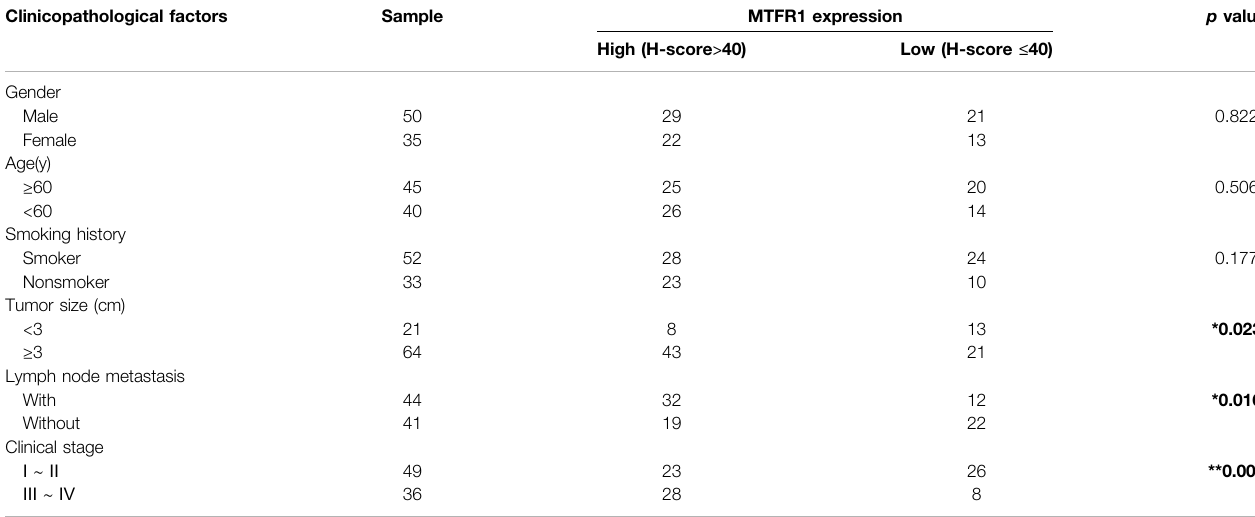
TABLE 1 | Correlation between MTFR1 expression and clinicopathological features in LUAD. Clinicopathological factors